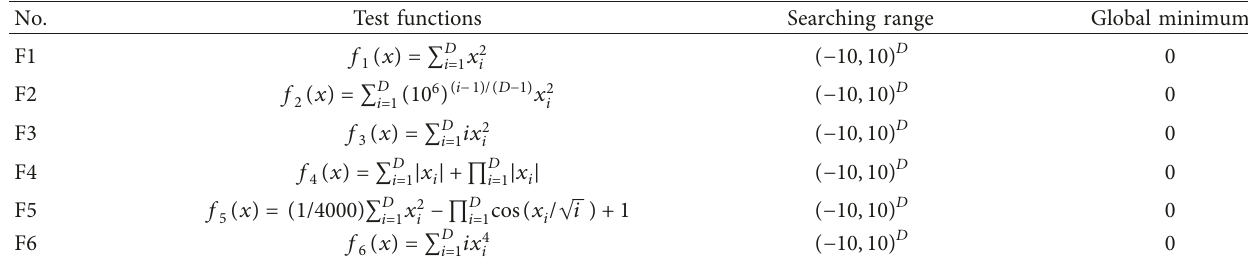
Figure 4: The 24 m benchmark beam. Table 1: Used explicit test